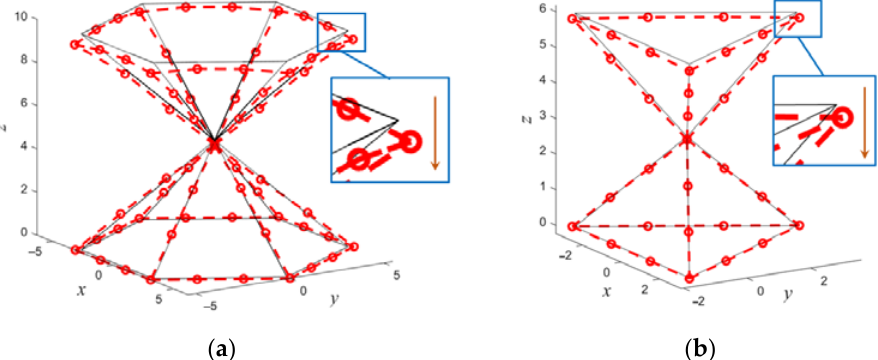
Figure 7. Optimization result of hourglass unit cell with a negative thermal deformation: ( a ) hexag- onal type; ( b ) triangular type. Note: the circular dot represents the FEM nodes of a beam element.